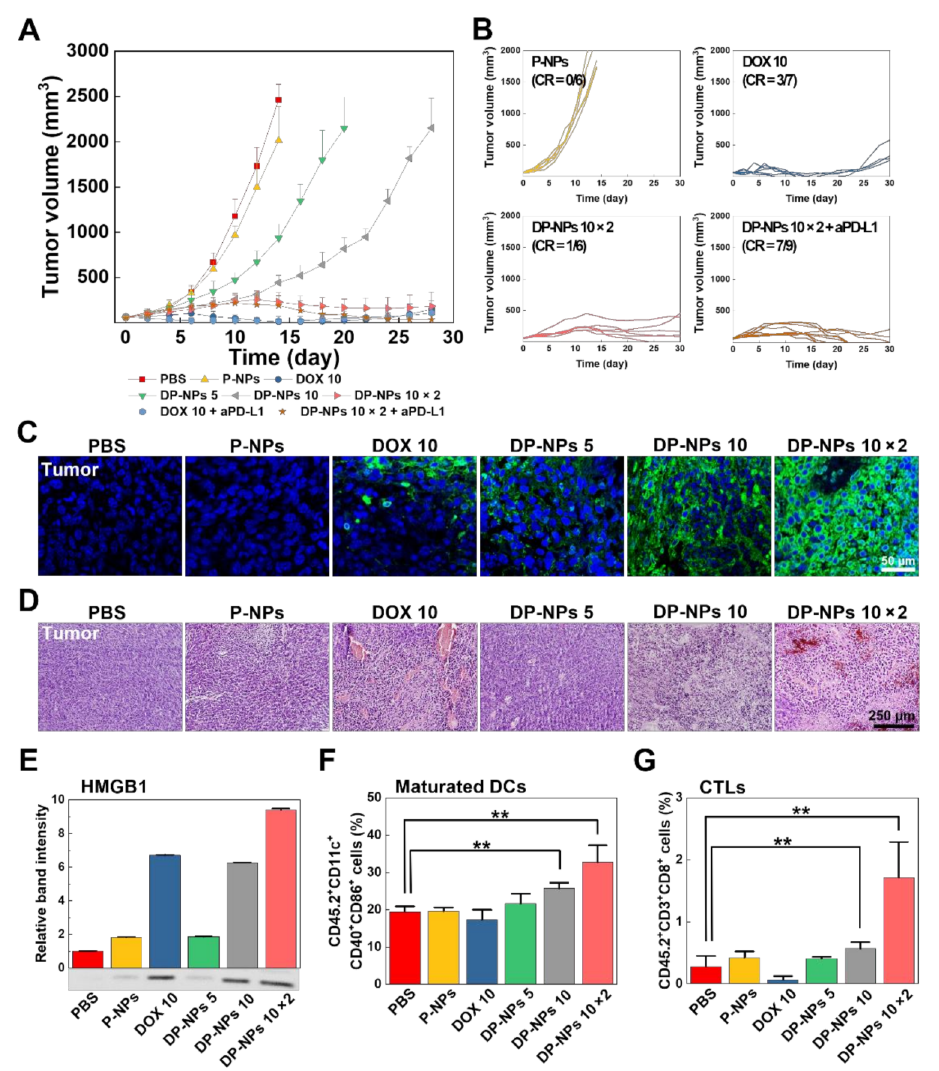
Figure 4. In vivo tumor growth inhibition and the subsequent antitumor immune responses. ( A ) Tumor growth of the CT26 tumor-bearing mice after the first intratumoral injection of PBS, P-NPs, DOX-HCl (10 mg/kg), DP-NPs (5, 10, 10 × 2 mg/kg), aPD-L1 Ab (10 × 5 mg/kg)-combined DOX-HCl (10 mg/kg), and DP-NPs (10 × 2 mg/kg) for 4 weeks. ( B ) Tumor growth for individual mice and CR rate in P-NPs-, DOX-HCl-, DP-NPs-, and aPD-L1 Ab-combined DP-NPs-treated groups of ( A ). Representative images of ( C ) TUNEL- and ( D ) H&E-stained tumor tissues at 14 days after the first treatment of PBS, P-NPs, DOX-HCl (10 mg/kg), and DP-NPs (5, 10, 10 × 2 mg/kg). TUNEL- positive cells are visible as green. The scale bars indicate 50 and 250 µ m, respectively. ( E ) Western blotting image and band intensity of in vivo HMGB1 at 14 days after the first treatment of PBS, P-NPs, DOX-HCl (10 mg/kg), DP-NPs (5, 10, 10 × 2 mg/kg). Immune cell population of ( F ) maturated DCs in TDLNs and ( G ) CTLs in tumor tissues at 14 days after the first treatment of PBS, P-NPs, DOX-HCl (10 mg/kg), and DP-NPs (5, 10, 10 × 2 mg/kg), analyzed using a flow cytometer. Double asterisks (**) indicate a difference at the p < 0.01 significance